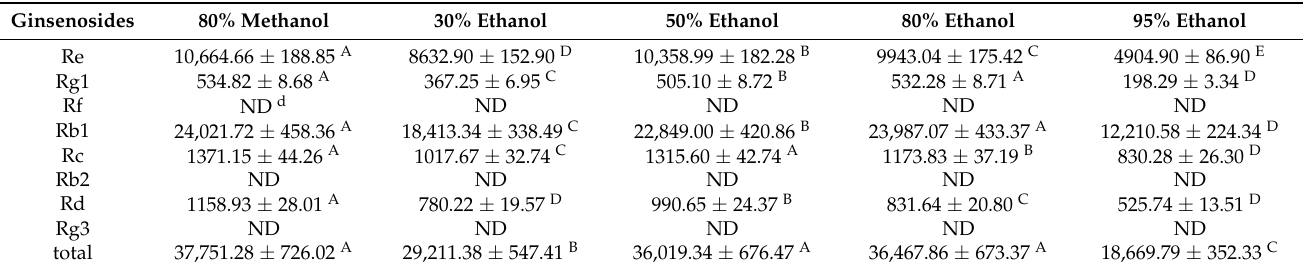
Table 5. Contents ( µ g/g) of ginsenosides in American ginseng root residue as affected by different extraction solvents based on HPLC-DAD-ESI-MS analysis a,b,c